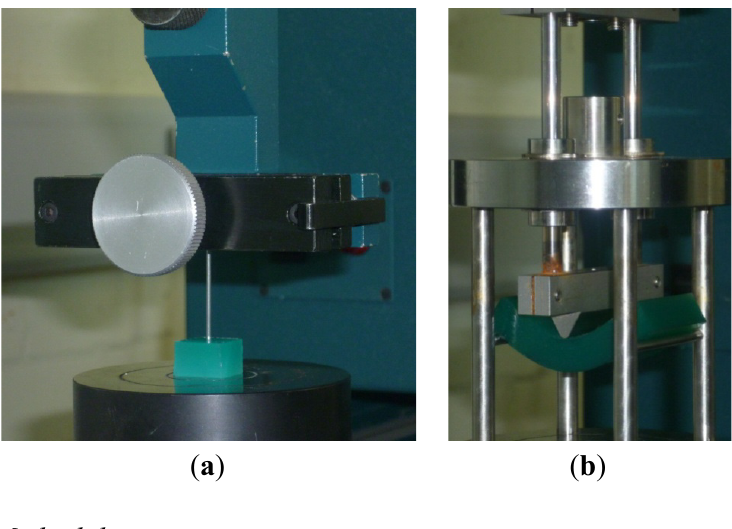
Figure 2. ( a ) Indentation and ( b ) deflection test methods for squeegees. Deflection test shows 10 mm tool